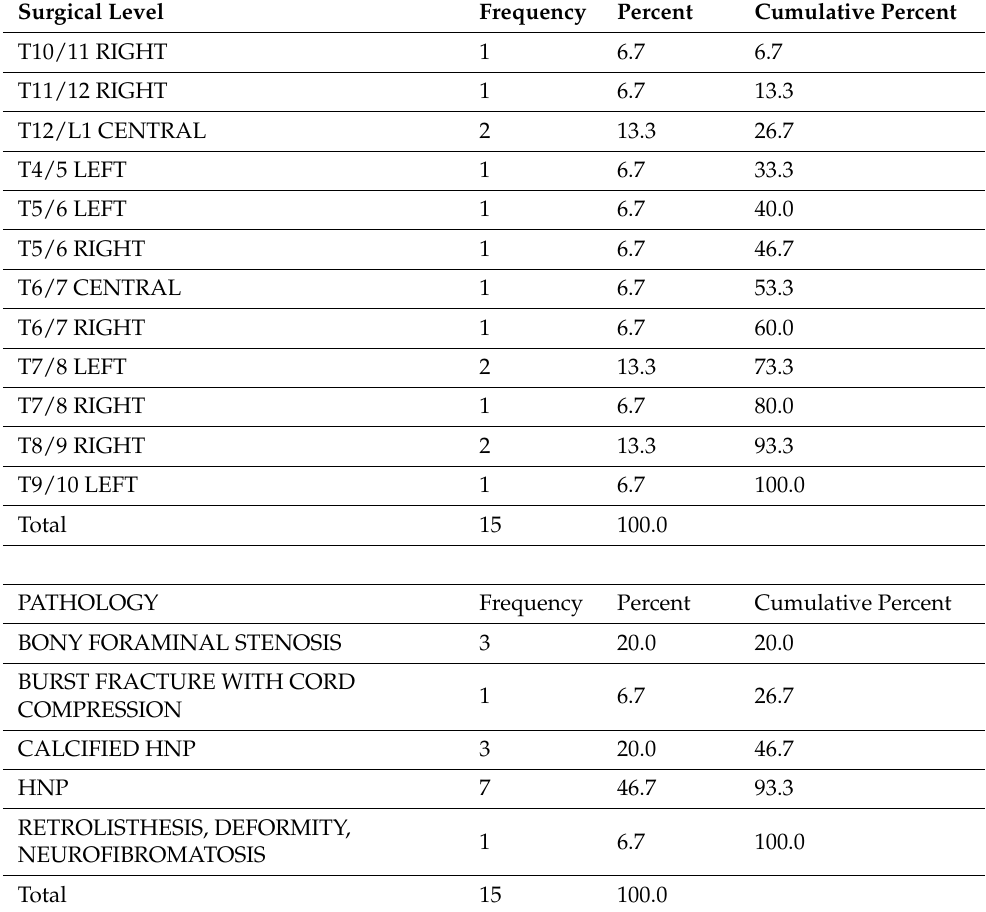
Table 2. Surgical level and symptomatic pathology.